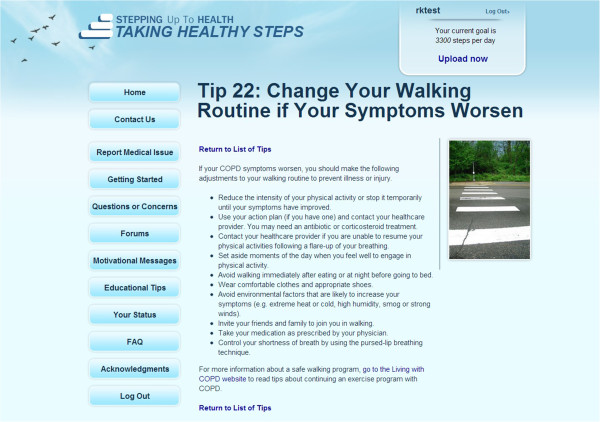
Example of the informational messages provided for participants in Taking Healthy Steps.